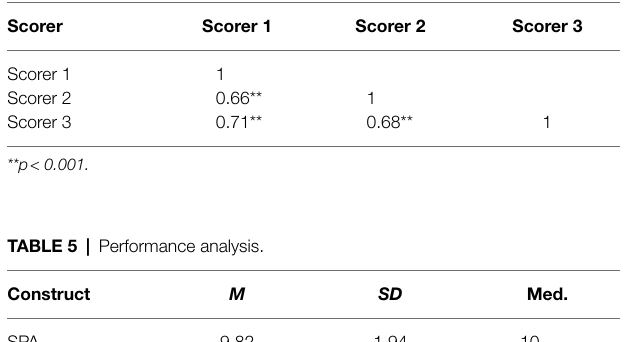
TABLE 4 | Intra-rater reliability analysis.